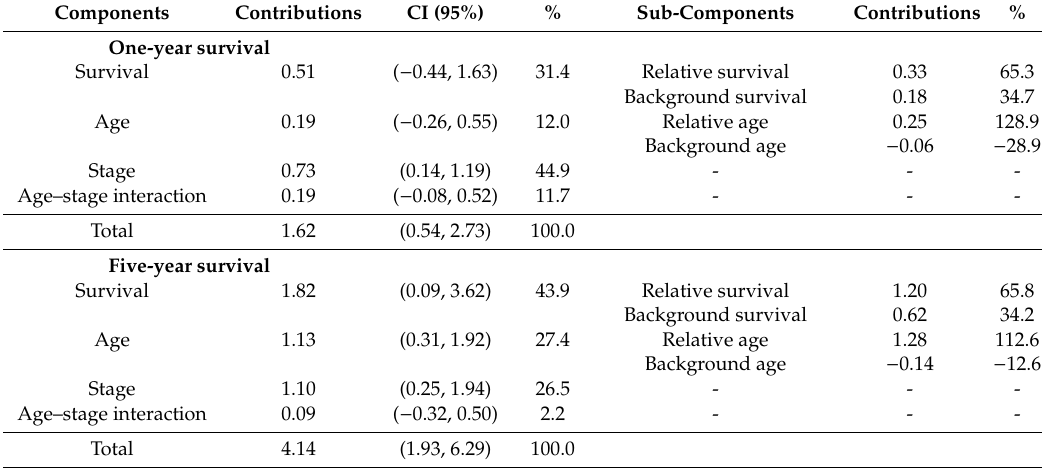
Table 3. Decomposition of the di ff erence in breast cancer one-year and five-year crude survival. between Zealand and Central Denmark,